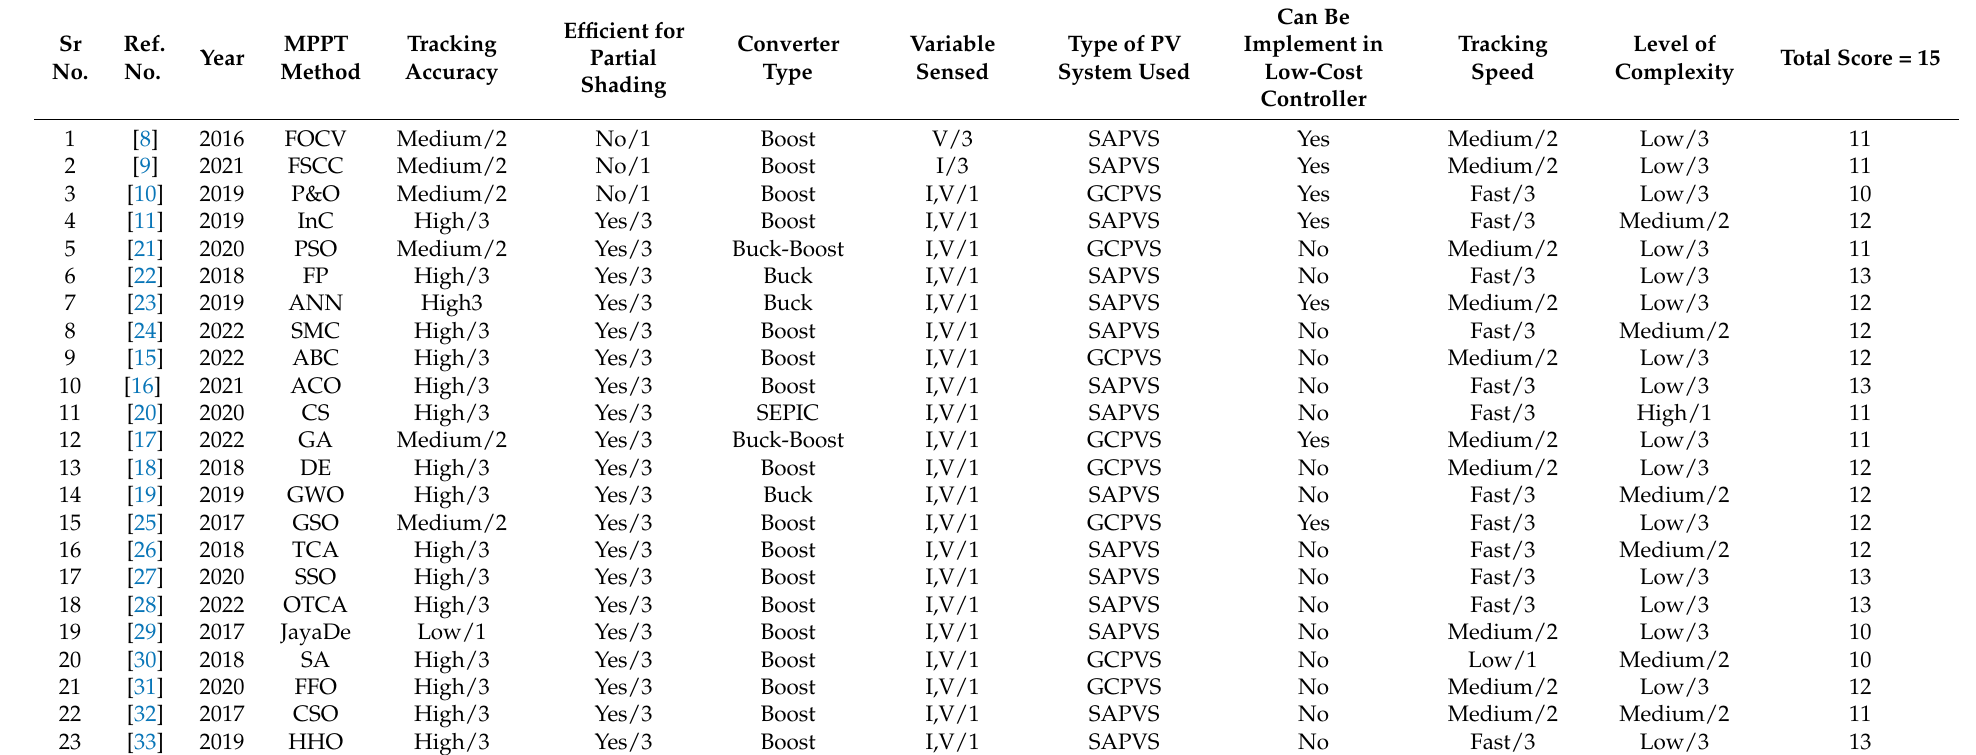
Table 1. Performance comparison of MPPT